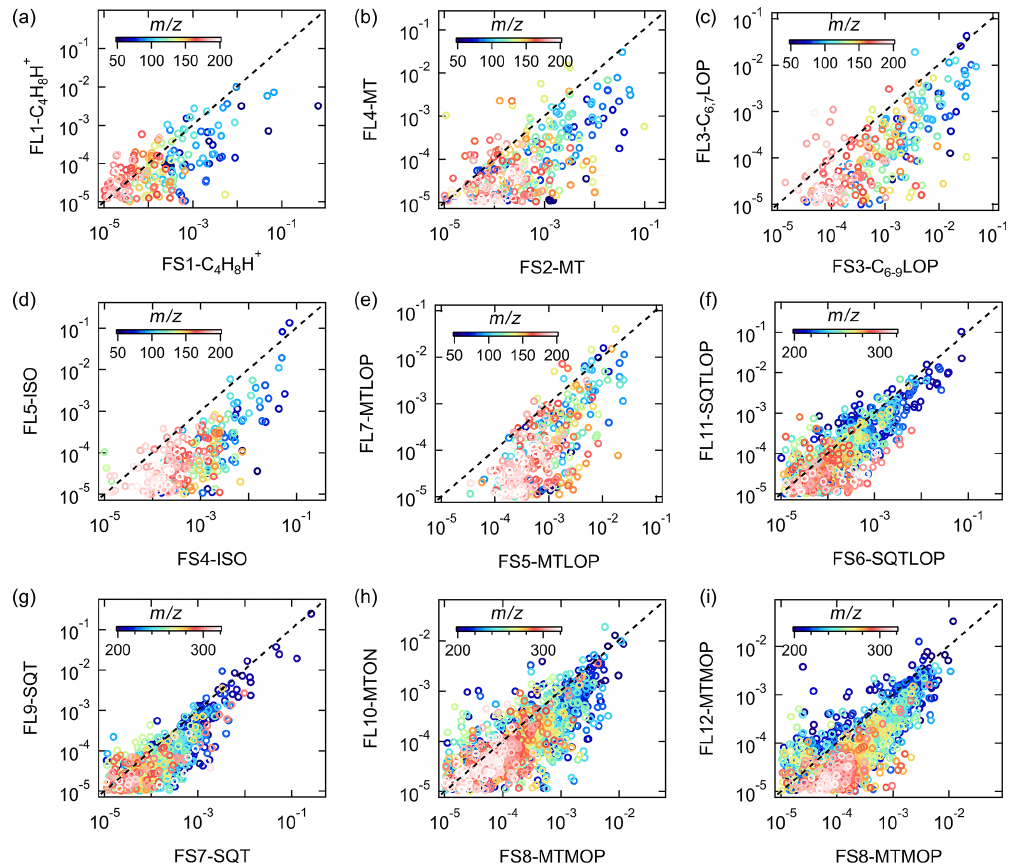
Figure 13. Comparison between factor profiles of the common sources apportioned in the Landes forest and at the SMEAR II station. The x and y axes show the fraction of each bin in the mass spectra of the factors. FL: factors in the Landes forest; FS: factors at the SMEAR II station; C 4 H 8 H + : C 4 H 8 H + ion-related; C 6 , 7 LOP: C 6 and C 7 lightly oxidized products; MT: monoterpenes; C 6 − 9 LOP: C 6 –C 9